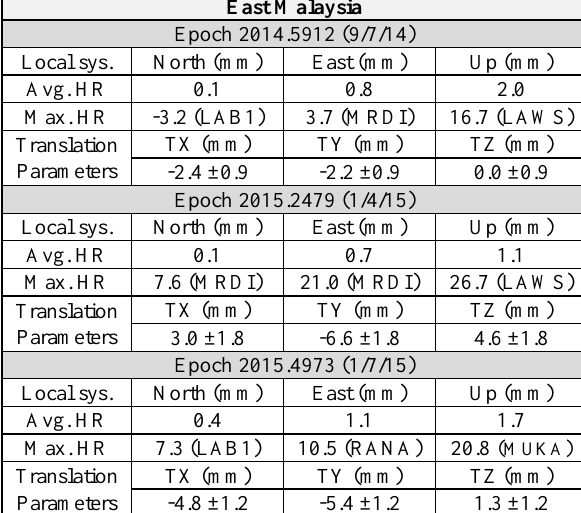
Table 9. The average and maximum Helmert residual in local system and the translation values for each of the validation epochs for East